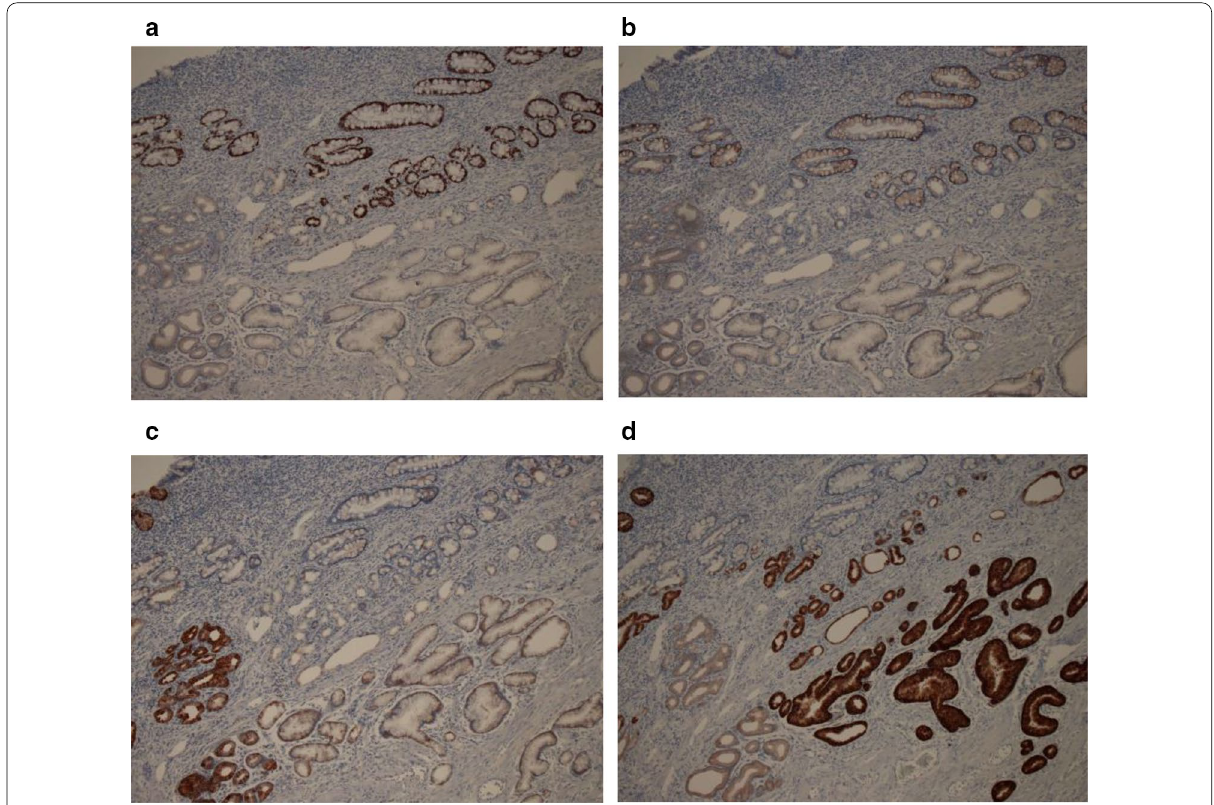
Fig. 4 Immunohistochemistry. a CDX2 ( 100). The mucosal epithelium of the small intestine was positive and the gastric crypt-like epithelium × was negative. b MUC2 ( 100). The goblet epithelium of the mucosa of the small intestine was positive and the gastric crypt-like epithelium was × negative. c MUC5AC ( 100). The mucosal epithelium of the small intestine was negative and the superficial gastric crypt-like epithelium was × positive. d MUC6 ( 100). The mucosal epithelium of the small intestine was negative and the gastric crypt-like epithelium was ×